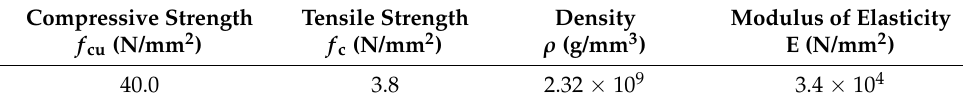
Table 1. Physical and mechanical parameters of concrete. Compressive